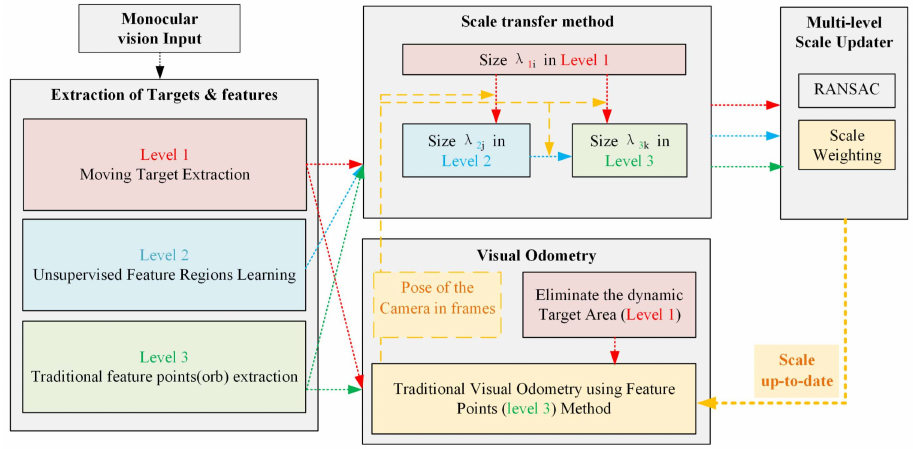
Figure 5. Multi-level scale stabilization algorithm: the red part corresponds to the features in Level 1; the blue part corresponds to the features in Level 2; the green part corresponds to the features in Level 3; the yellow part corresponds to the original visual odometry (VO) and the update for scale T